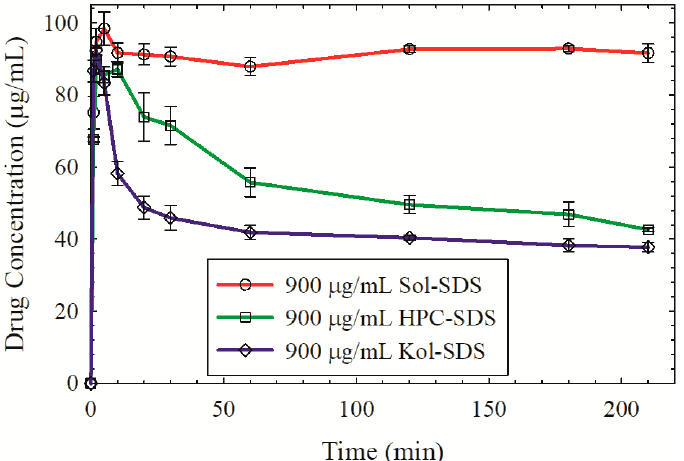
Figure 8. Effects of polymer–SDS on the precipitation inhibition from supersaturated solutions of griseofulvin with an initial concentration of ~100 μ g/mL. The test fluid contains 900 μ g/mL of polymer–SDS equivalent to 10% GF–polymer formulations. Error bar represents the standard deviation ( n = 3).